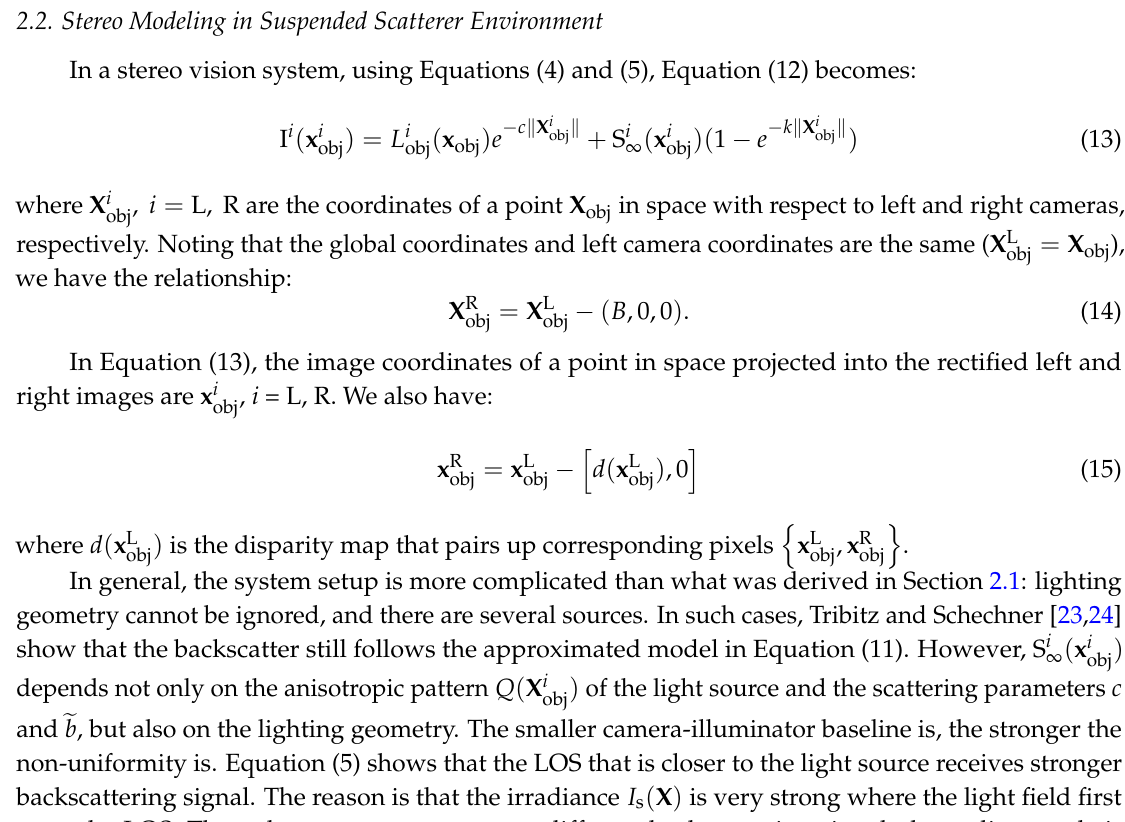
Figure 1. Stereo vision system